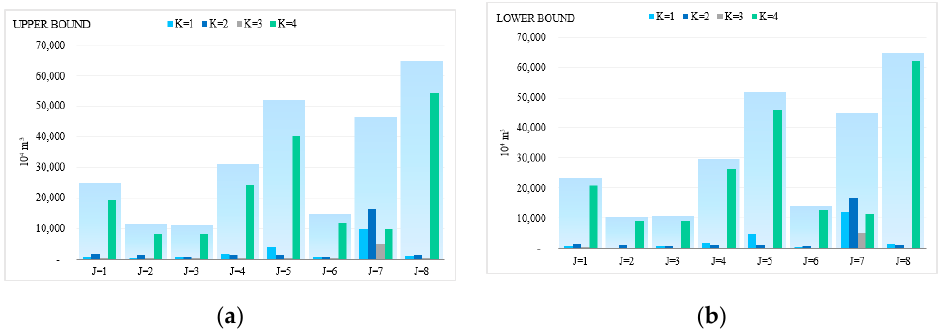
Figure 8. Optimal scheme of water resources distribution in the Yinma River Basin in the first planning period. ( a ) Upper bound of water resources; ( b ) Lower bound of water resources.